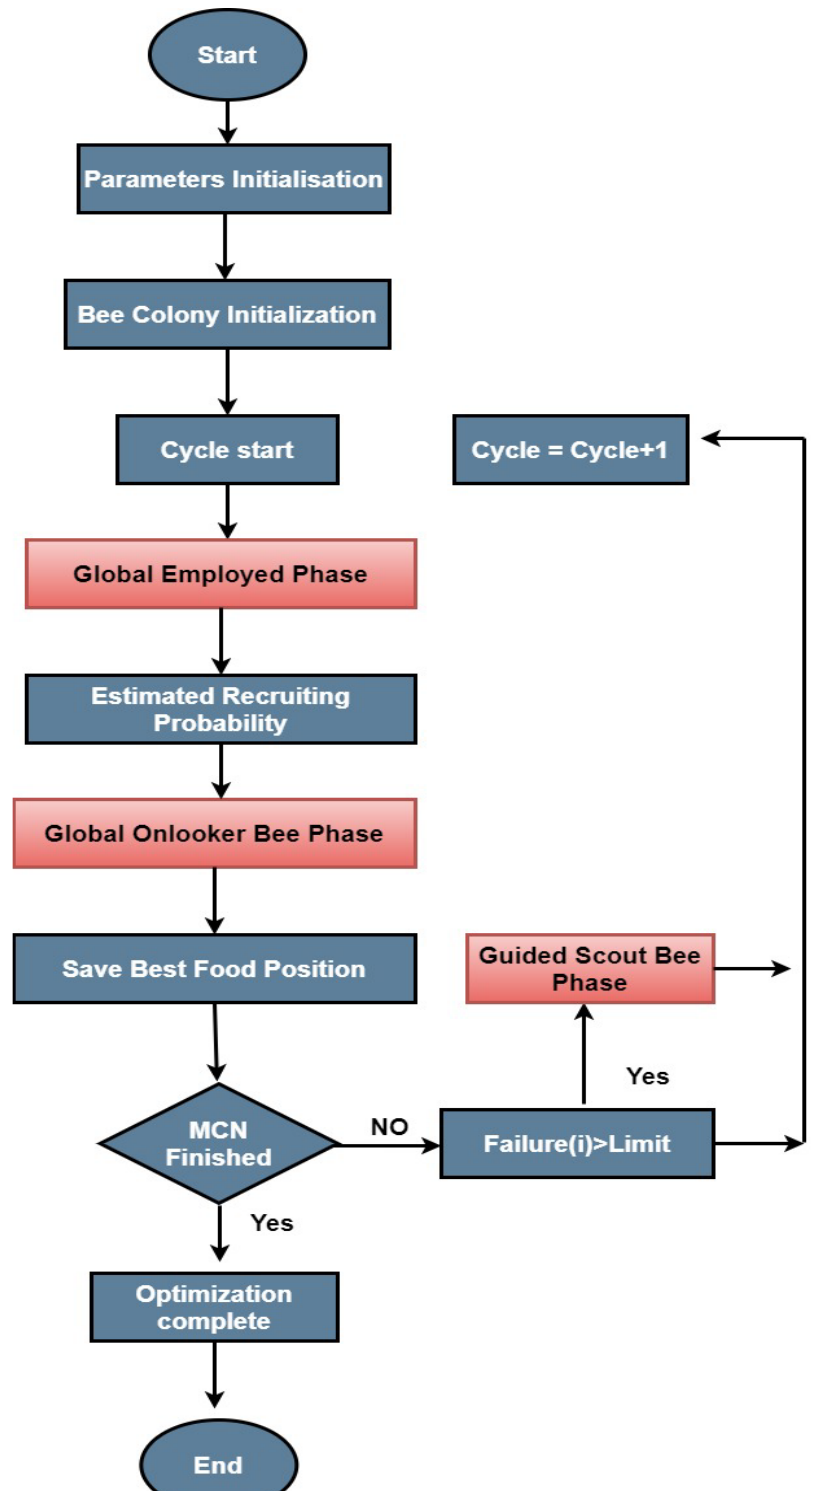
Figure 7. Working phase of the ABC algorithm.